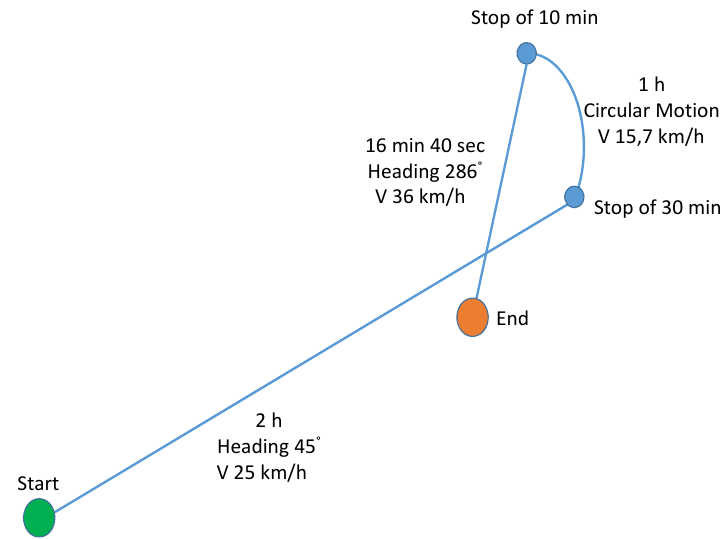
Figure 4. Schematic representation of the simulated test for the proposed radiolocation algorithm. The target ship (transmitter) departs from point ’Start’ and arrives to point ’End’ moving with the described speeds and